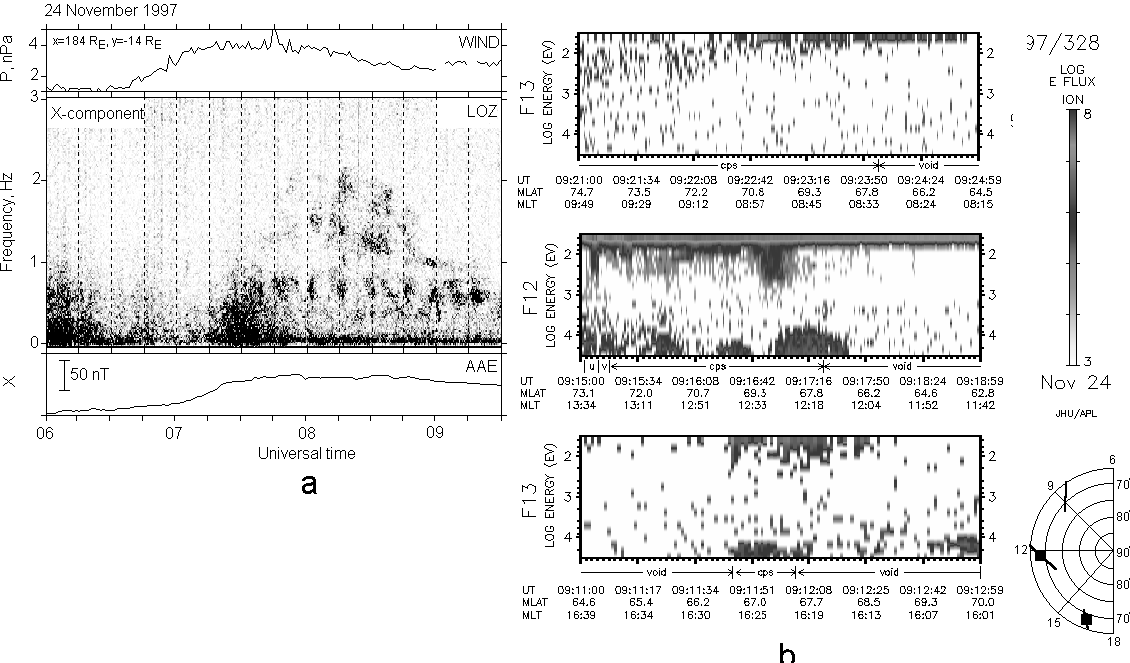
Fig. 9. Hot protons in the dayside magnetosphere during the “YES event”. (a) Variations of dynamic pressure on the WIND satellite (top panel), corresponding increase of geomagnetic field at equatorial station (bottom panel) and ULF response in dayside auroral zone (middle panel). (b) DMSP particles data in the dawn, midday and dusk sectors of magnetosphere. The precipitating areas are indicated in the diagram (right bottom) with black